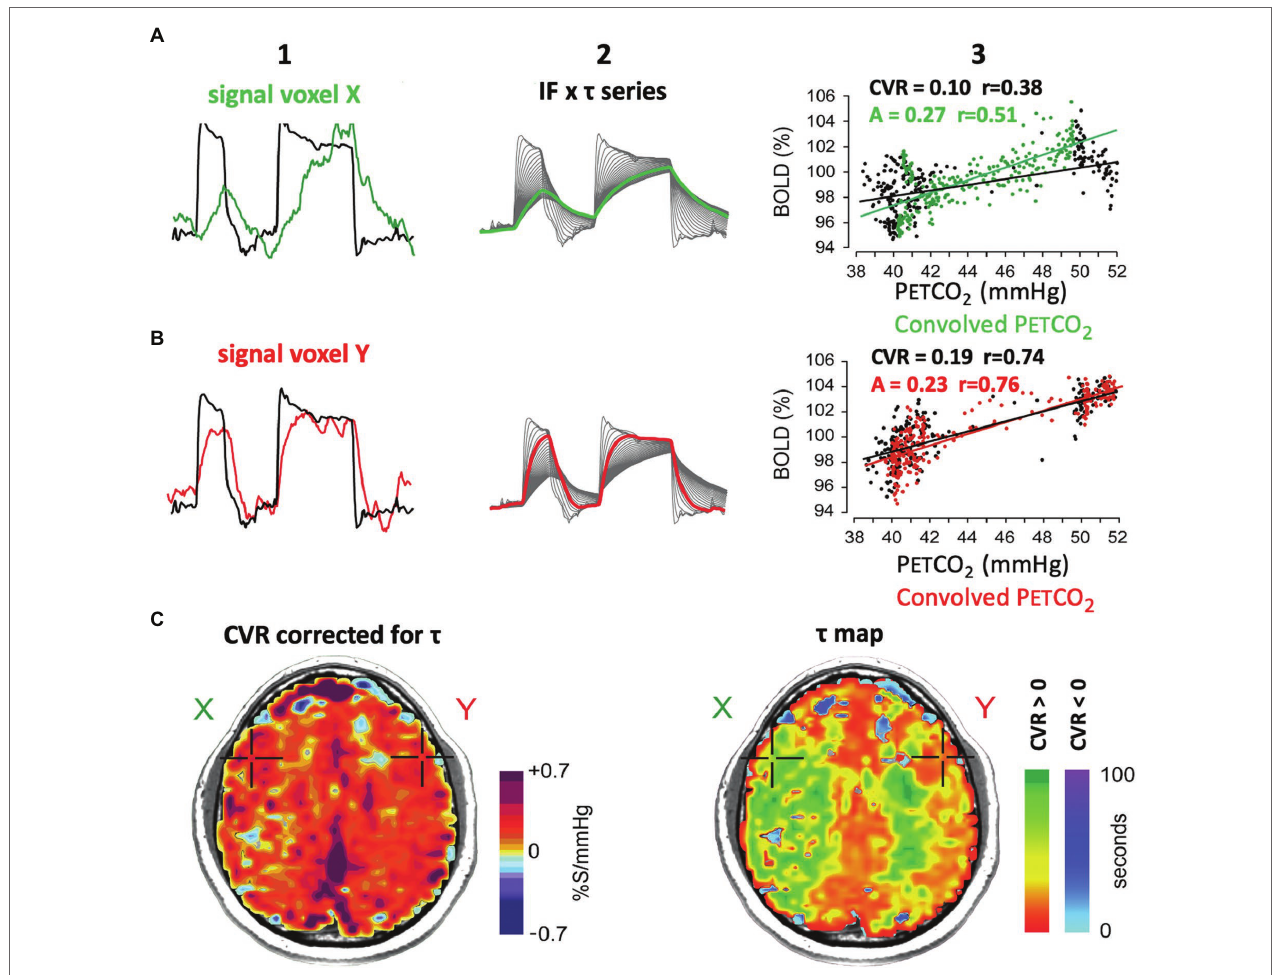
FIGURE 7 | Effect of the speed of vascular response to a stimulus on the measure of CVR. (A1, B1) : P ET CO 2 and BOLD signal for voxels shown in maps in row (C) . (A2, B2) : multiple versions of P ET CO 2 obtained by convolving the P ET CO 2 with an exponential function of time constant τ . The heavy line is the one that best fits the signal shown in A1 and A2 , and the associated τ characterizes the speed of vascular response (see Figure 1 in Poublanc et al., 2015). (A3, B3) : The black dots map the BOLD vs. P ET CO 2 , and the black line indicates the associated regression line. The green and red dots are BOLD signal graphed against convolved P ET CO 2 . The slopes of the green and red regression lines denote the amplitude of the signal corrected for its response time τ . (C) Right figure shows the distribution of τ in an axial slice. The slowed responses (indicated by the green coloration) would tend to reduce the CVR value calculated from actual P ET CO 2 and increase the “steal” colors calculated by line of best fit alone (see images on left in Figure 4 ). (C) : Left figure. The CVR map shows a normal CVR after mathematically correcting for the slowed τ . This shows that abnormal CVR calculations without correcting for τ would be due to a slowed τ